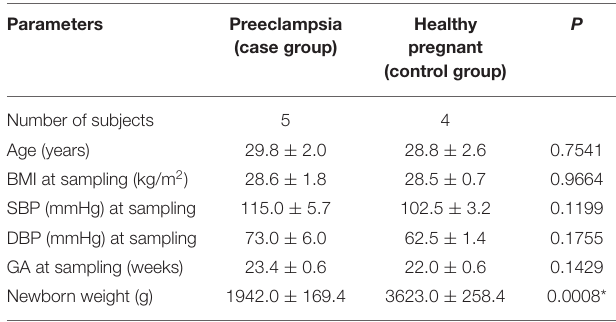
TABLE 1 | Demographic and clinical characteristics of subjects enrolled in the